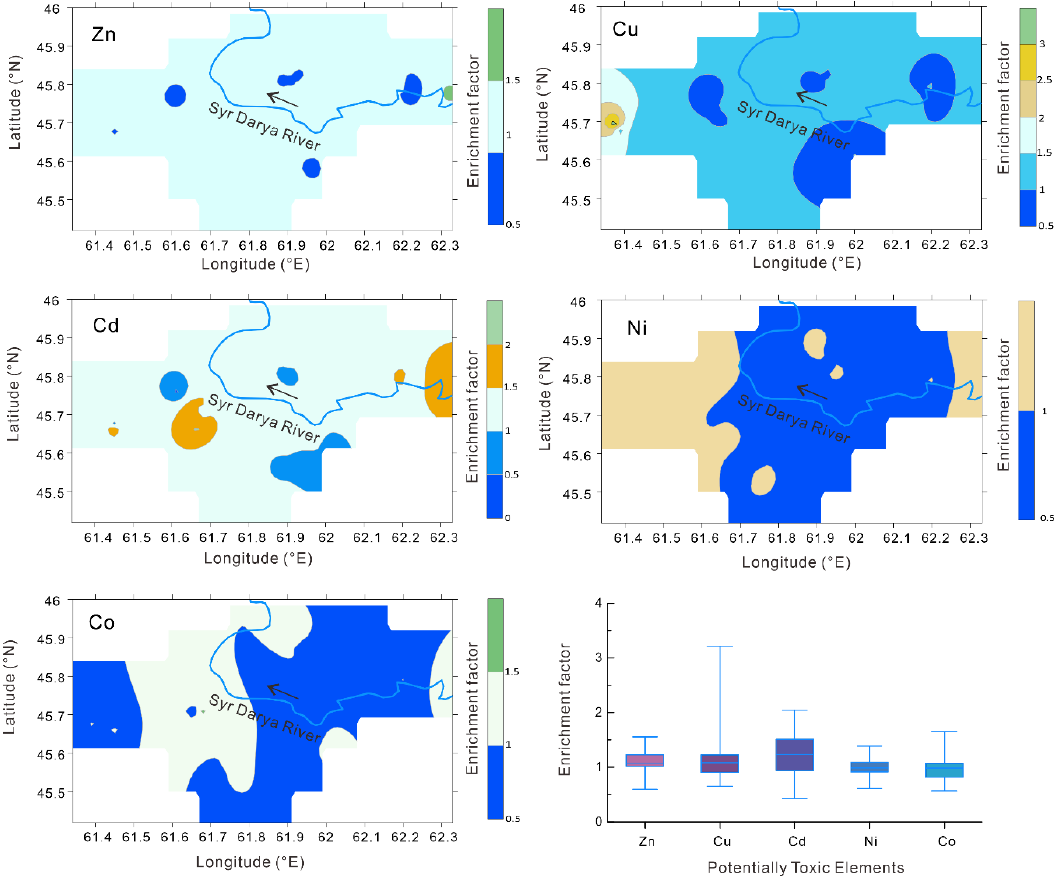
Figure 6. Basic statistical chart and spatial distribution maps of the enrichment coefficients of the potentially toxic elements in sampling region